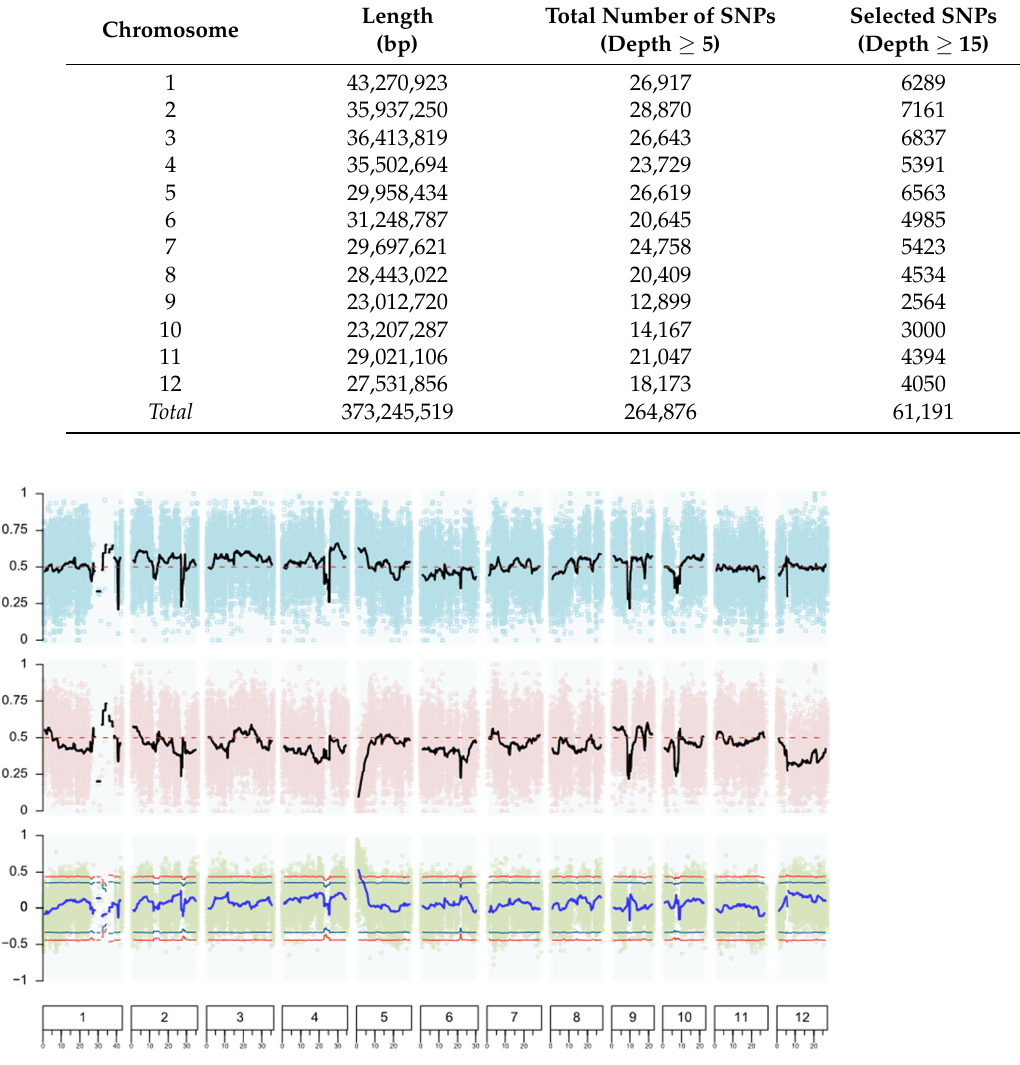
Table 2. Chromosome-wise distribution of single-nucleotide polymorphisms (SNPs) between the two bulks.